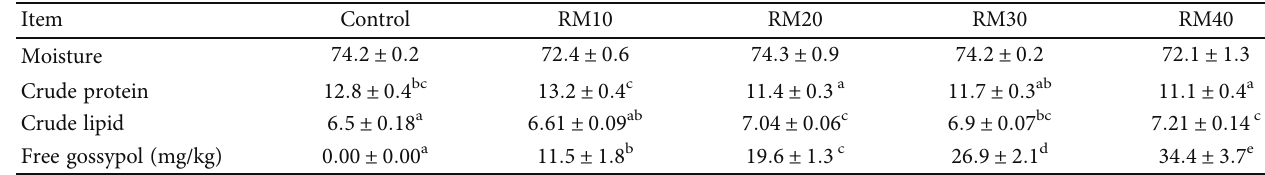
Table 4: E ff ects of dietary mixed plant protein substitute for fi sh meal on the proximate composition (percentage of live weight) and free gossypol content (mg/kg) in the liver of yellow cat fi sh. Item Control RM10 RM20 RM30 RM40 Moisture